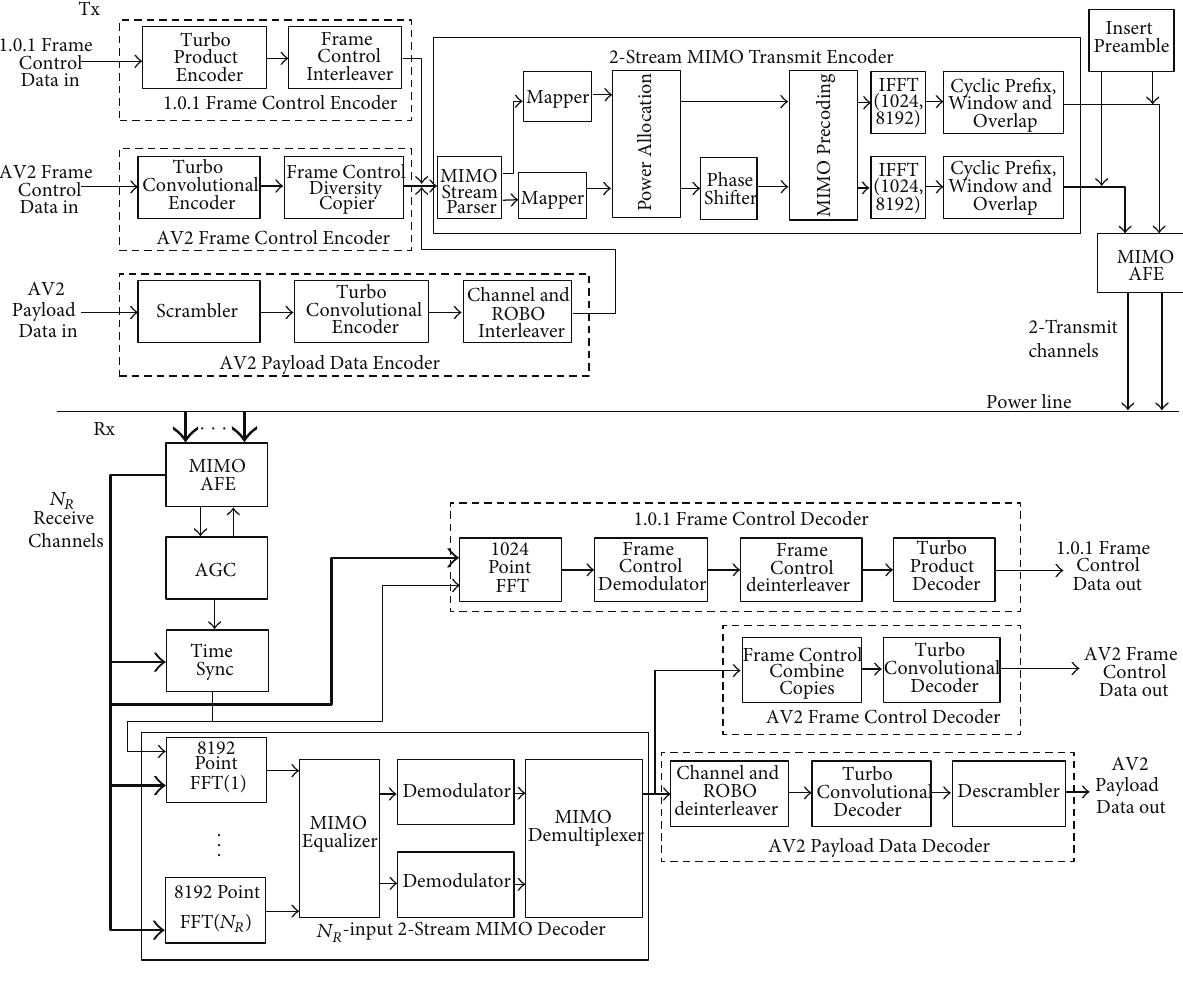
Figure 1: HomePlug AV2 transmitter and receiver PHY